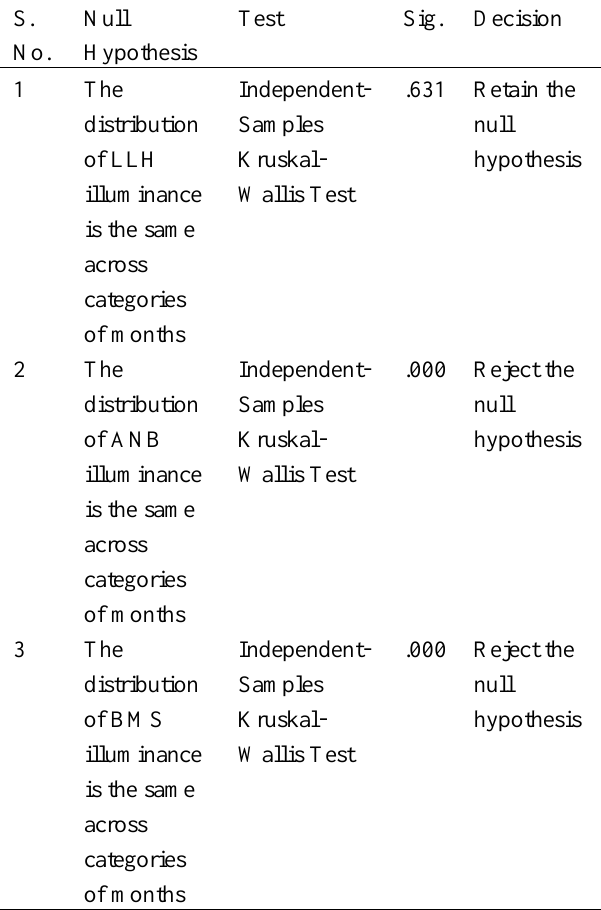
Hypothesis test summary of difference in illuminance per month of each strategy (Asymptotic significances are displayed and the significance level is